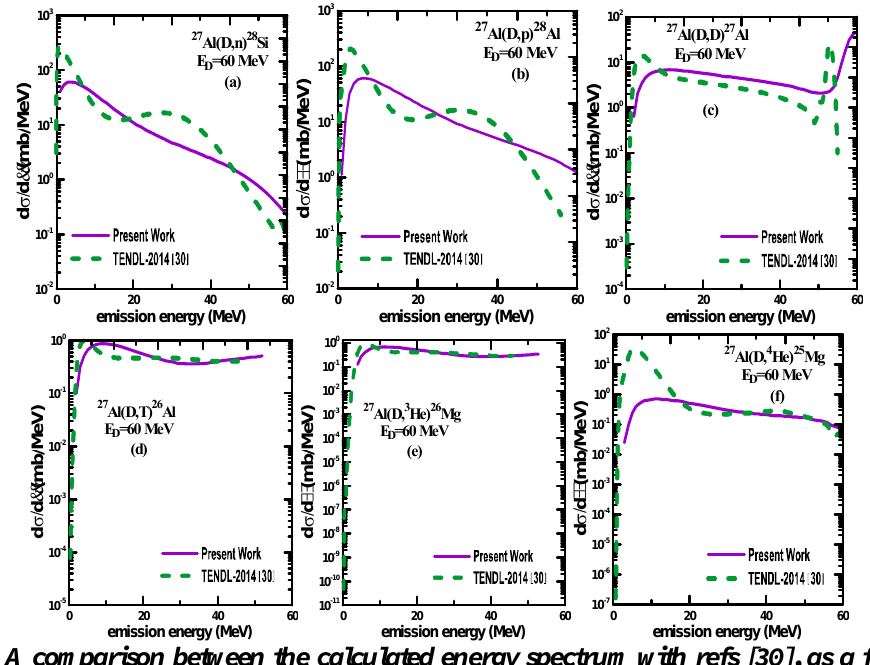
Fig. 4: A comparison between the calculated energy spectrum with refs [30], as a function of particle emission energy in cm-system at 60 MeV incident deuterium for the reactions, (a) 27 Al (D, n) 28 Si (b) 27 Al (D, p) 28 Al (c) 27 Al (D, D) 27 Al (d) 27 Al (D, T) 26 Al (e) 27 Al (D, 3 He) 26 Mg (f) 27 Al (D, 4 He) 25 Mg.